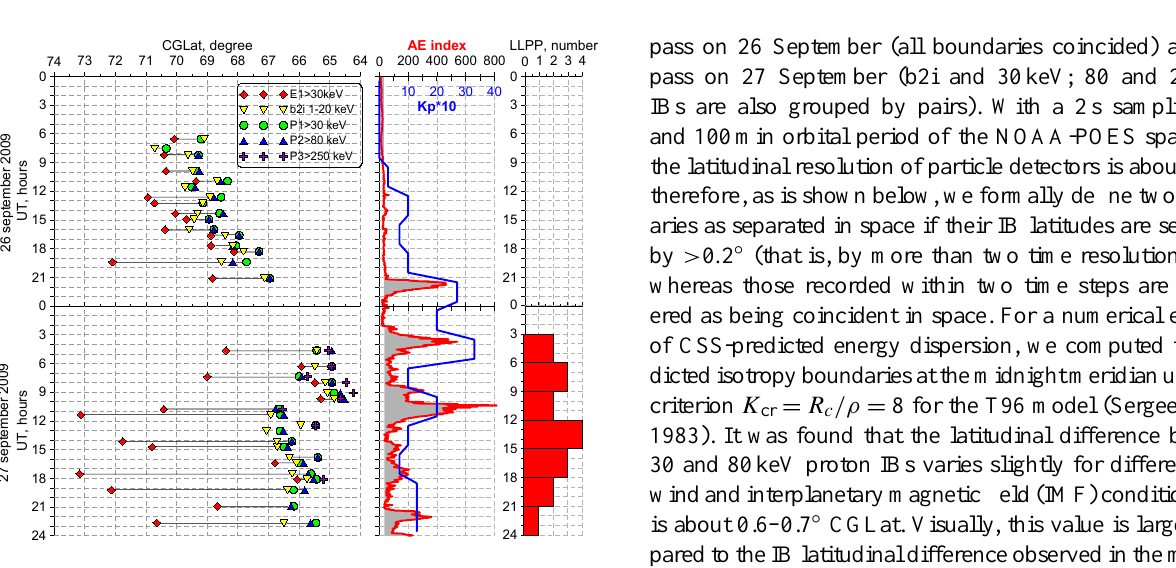
Figure 3. Survey of activity and IB dispersion patterns on 26 and 27 September 2009. From left to right: IB locations at different en- ergies during NOAA-19 crossings in postmidnight MLT; AE and Kp activity; and number of LLPP precipitation events (equatorward of proton IB locations) in 3h UT bins identified in the NOAA-19